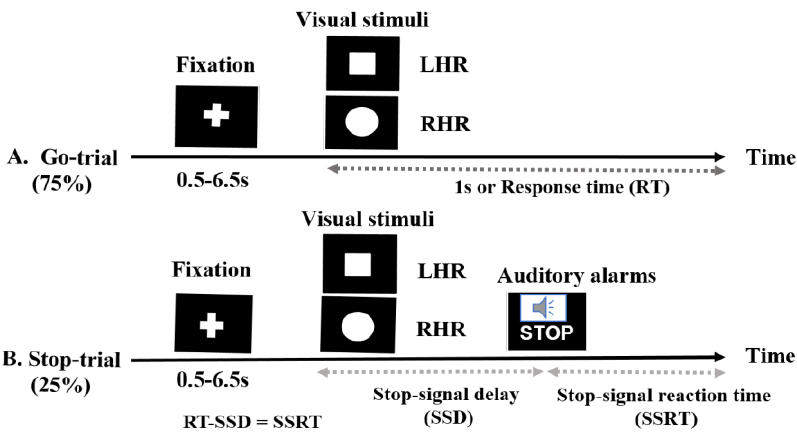
Figure 1. The stop signal task used for visual stimuli and auditory alarms: ( A ) In the go-trials, participants responded to the shape of a go stimulus (a “square” requires a left-hand response (LHR) and a “circle” requires a right-hand response (RHR). The square and a circle shapes were used as visual stimuli. ( B ) In the stop-trials, a beep sound (auditory alarm) was used as a stop signal, to instruct the participants to control their response. The behavioral parameters measured in this experiment included fixation, reaction time (RT), stop signal delay (SSD) and stop signal reaction time (SSRT).